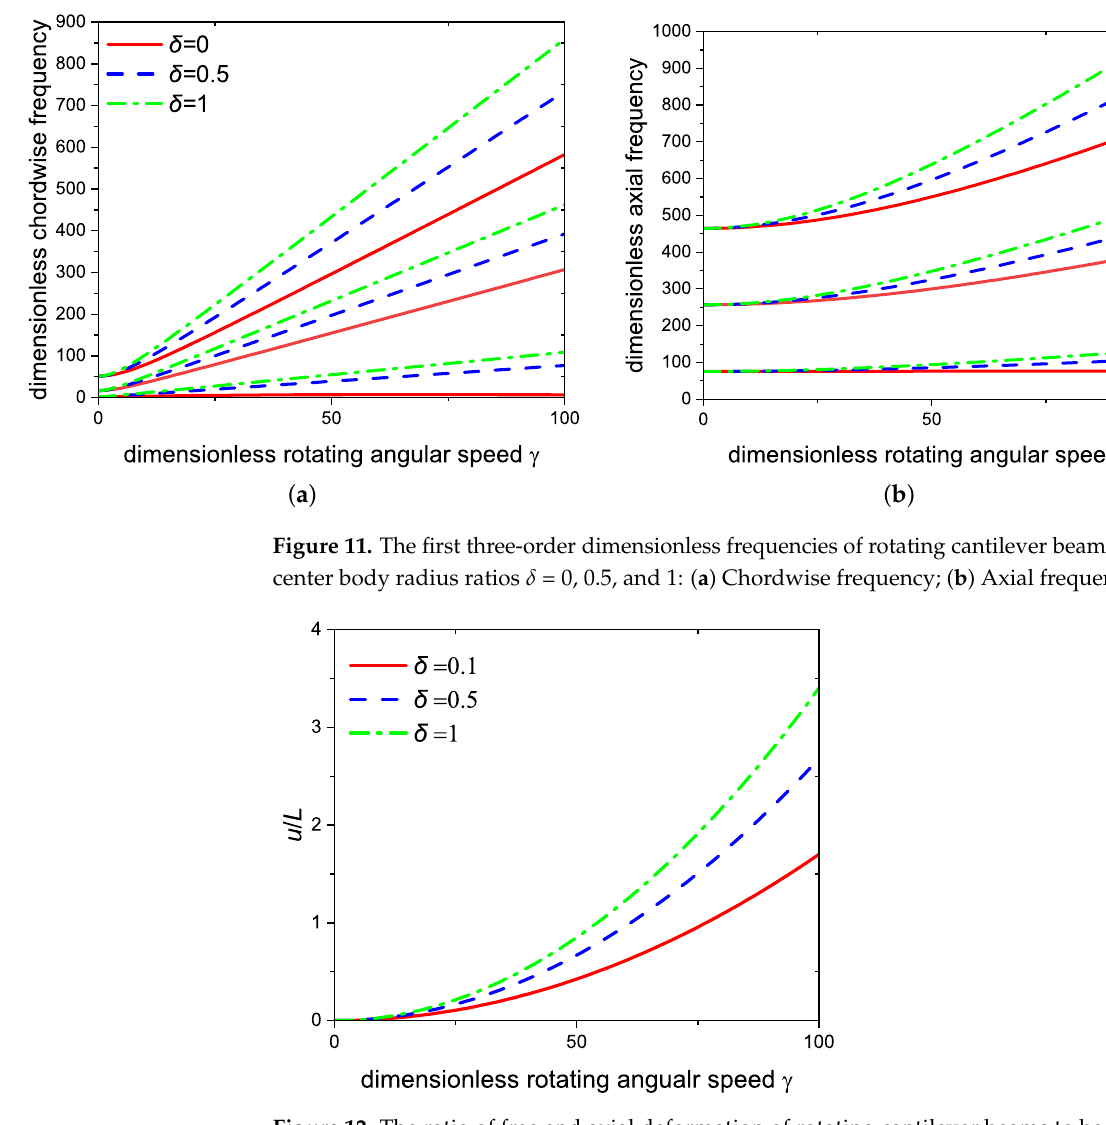
Figure 12. The ratio of free end axial deformation of rotating cantilever beams to beam length with different center body radius ratios δ = 0, 0.5, and